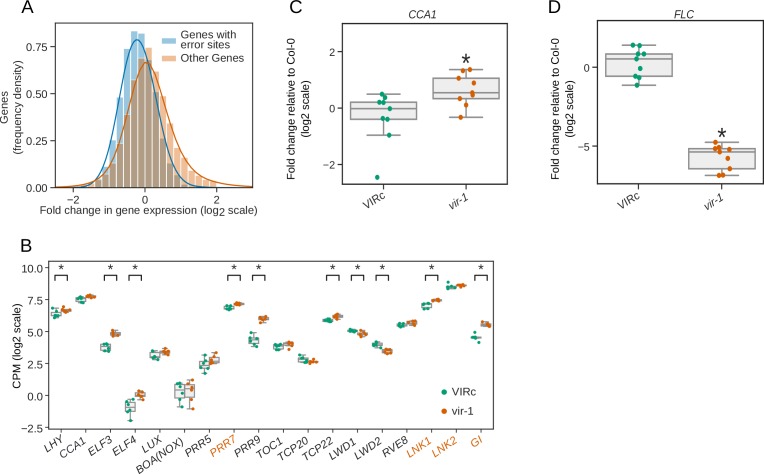
Changes in the gene expression of circadian clock components in the vir-1 mutant.(A) Histogram showing log2 fold changes in gene expression based on Illumina RNAseq data for the vir-1 mutant and VIRc. Blue, genes with differential error rate sites (n = 5,095 genes); orange, genes without differential error rate sites (n = 14,686 genes). (B) Expression of core circadian clock components is perturbed in the vir-1 mutant. Boxplots showing normalized gene expression measured using Illumina RNAseq in log2counts per million (CPM): green, the VIR-complemented line (VIRc); orange, the vir-1 mutant. Asterisks, significant expression changes (using an FDR threshold of 0.05); orange labelled genes, genes with 3′ UTR m6A detectable by nanopore DRS and miCLIP. Each scatter point represents a single biological replicate. UBIQUITIN LIGASE 21 (UBC21; AT5G25760) was used as a control. (C) Expression of CCA1, encoding a regulator of the circadian rhythm in Arabidopsis, is increased in the vir-1 mutant. Boxplot showing the gene expression change from Col-0 (measured by RT-qPCR) for VIRc (green) and vir-1 (orange). Three technical replicates of three biological replicates were conducted. Each scatter point represents the comparison of a technical replicate of treatment (VIRc or vir-1) against control (Col-0). The expression change in vir-1 is significant (p = 0.02; marked by asterisk). UBIQUITIN LIGASE 21 (UBC21; AT5G25760) was used as a control. (D) Expression of the Flowering Locus C (FLC) gene is decreased in the vir-1 mutant. Boxplot showing gene expression change from Col-0 (measured by RT-qPCR) for VIRc (green) and vir-1 (orange). Three technical replicates of three biological replicates were conducted. Each scatter point represents the comparison of a technical replicate of treatment (VIRc or vir-1) against control (Col-0). Expression change in vir-1 is significant (p = 2.4 × 10−14; marked by asterisk). The following source data are available for Figure 6—figure supplement 1.Figure 6—figure supplement 1—source data 1.Differential gene expression results for vir-1 vs VIRc, using counts derived from Illumina RNAseq – Figure 6—figure supplement 1A.Figure 6—figure supplement 1—source data 2.qPCR expression of CCA1 and FLC in Col-0, vir-1 and VIRc – Figure 6—figure supplement 1C.